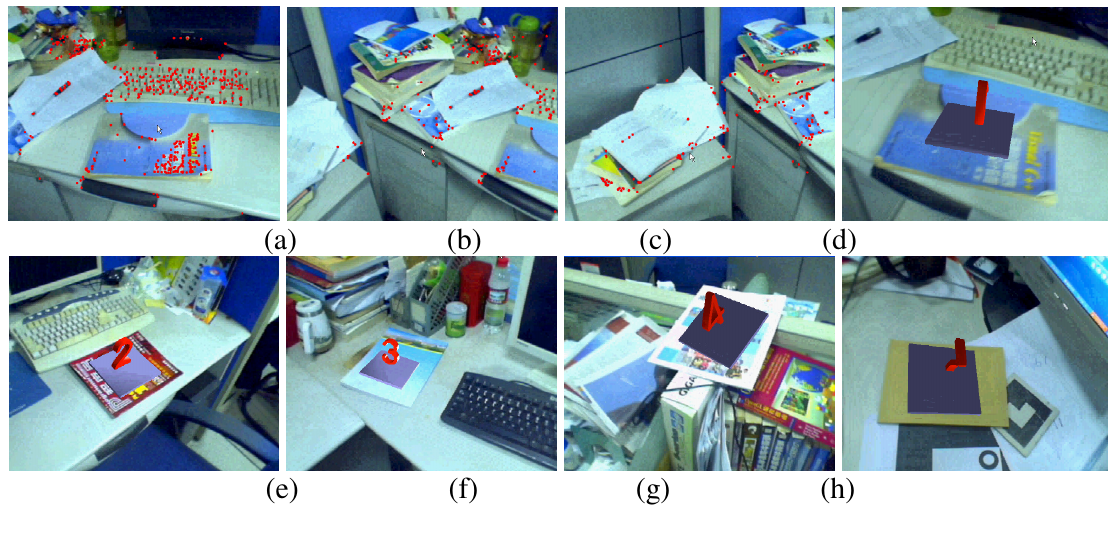
Figure 6. Mapping and augmentation